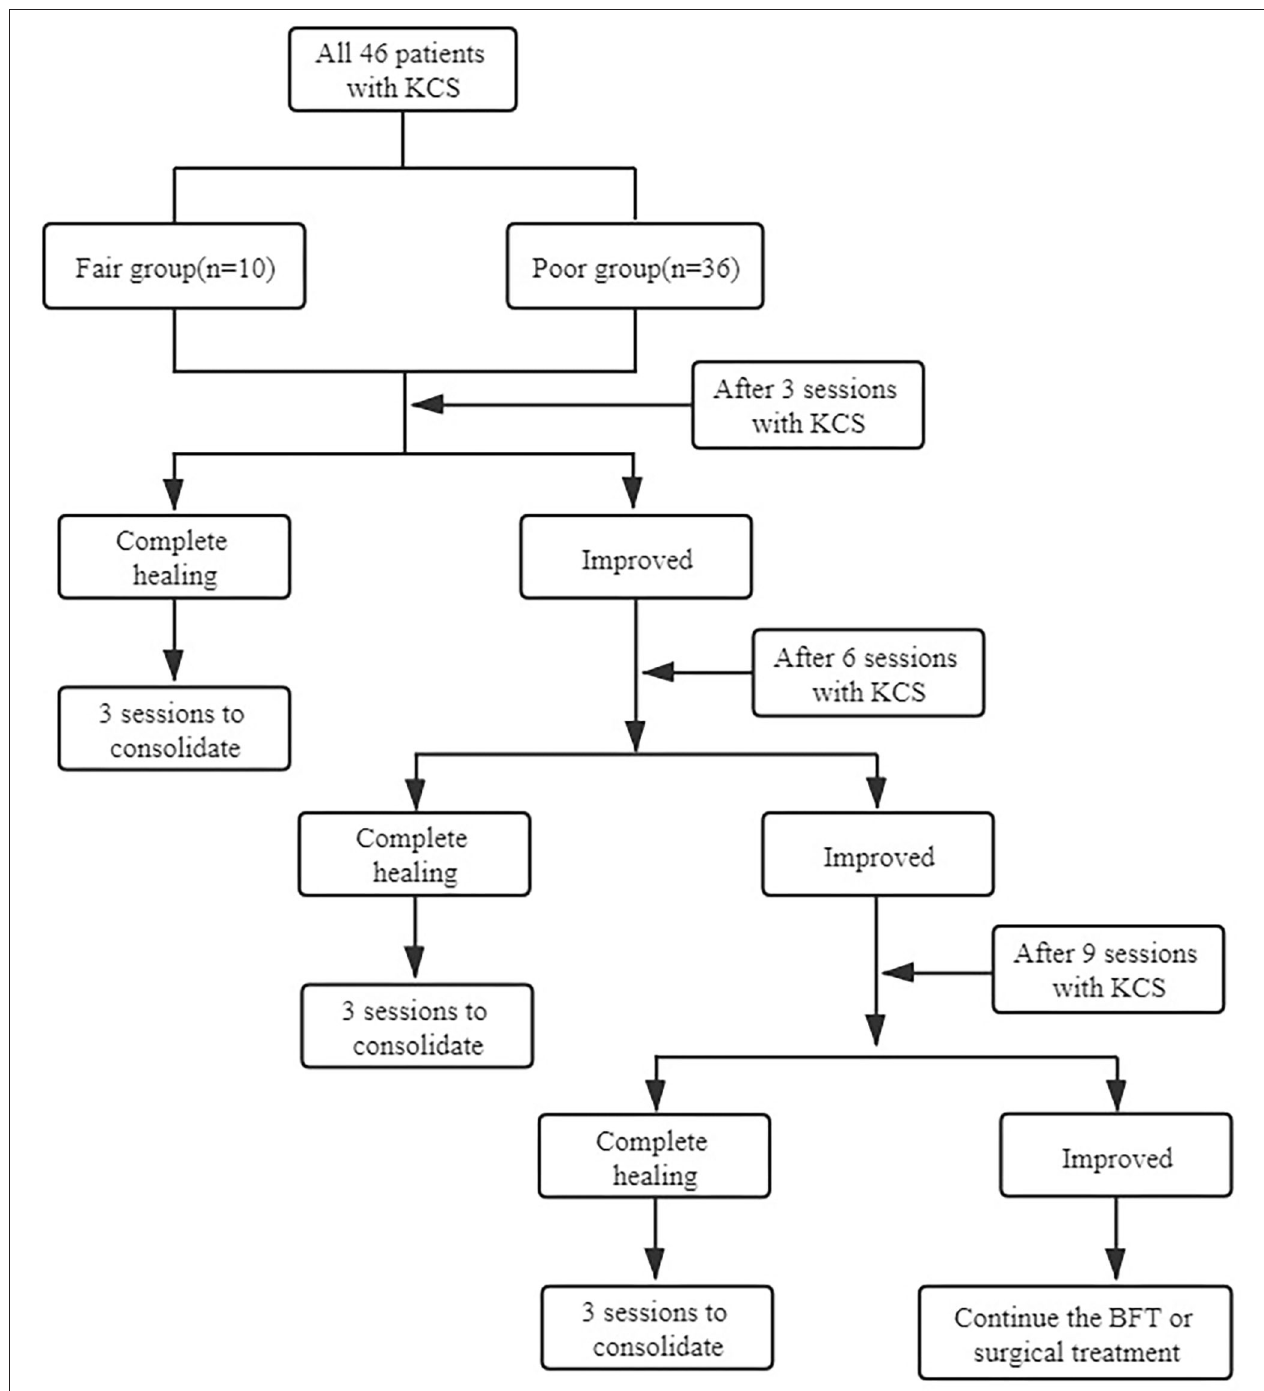
FIGURE 1 | The procedures to decide the timing to terminate treatment based on clinical symptoms.